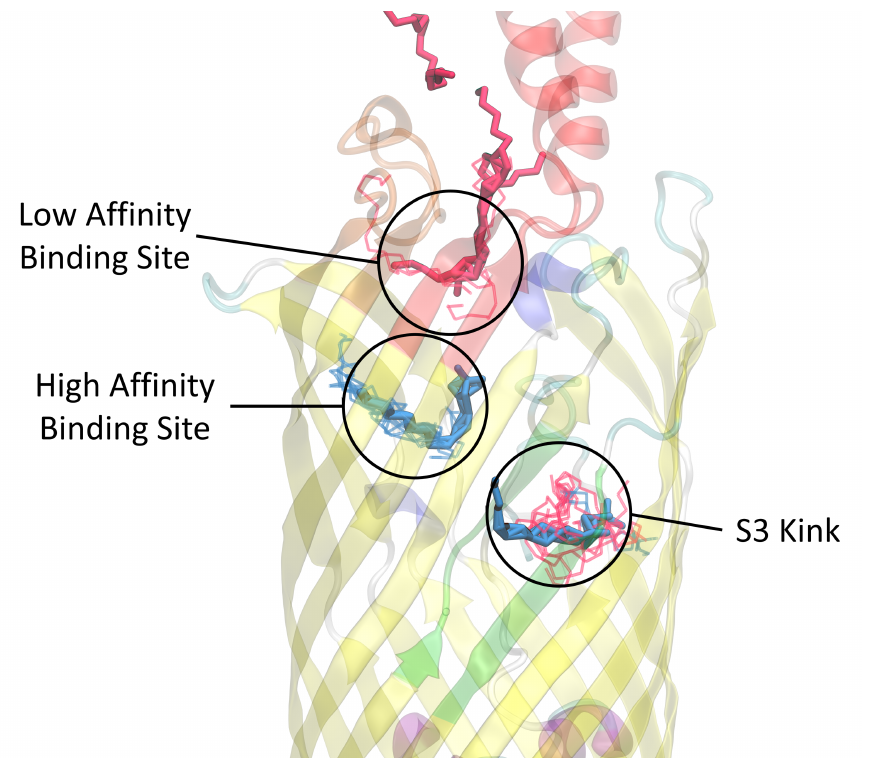
Figure 2. Docking of 1T16 with LDAO and C8E4 (lines) compared with the original LDAO and C8E4 (solid) placement from X-ray crystallography. While this is only one frame, the LDAO from docking tends to be strongly correlated to the crystallography bound LDAO, found in the high affinity binding site. The docked C8E4 was found to correspond to the crystallography bound C8E4 in the low affinity binding site, but the docked C8E4 was also found to bypass the transport channels and appear docked around the crystallography bound LDAO found the S3 kink. This occurrence is likely an effect of AutoDock’s ligand placement algorithm and non-competitive docking). The L3 loop is colored red, the L4 loop is colored orange, and the S3 kink is colored green for reference.